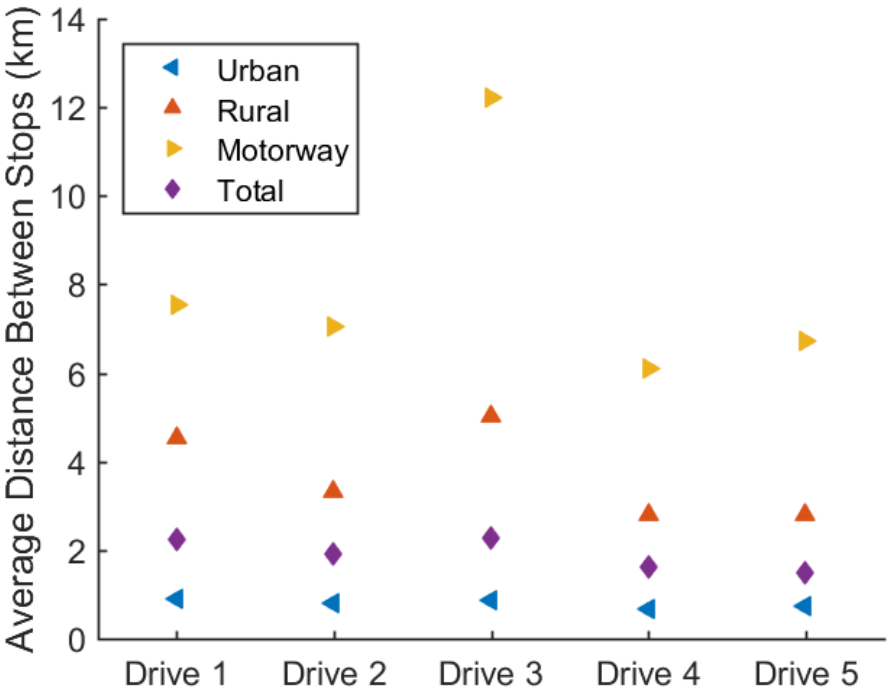
Figure 10. Average distance between stops for each section of the drive, by topographical map.